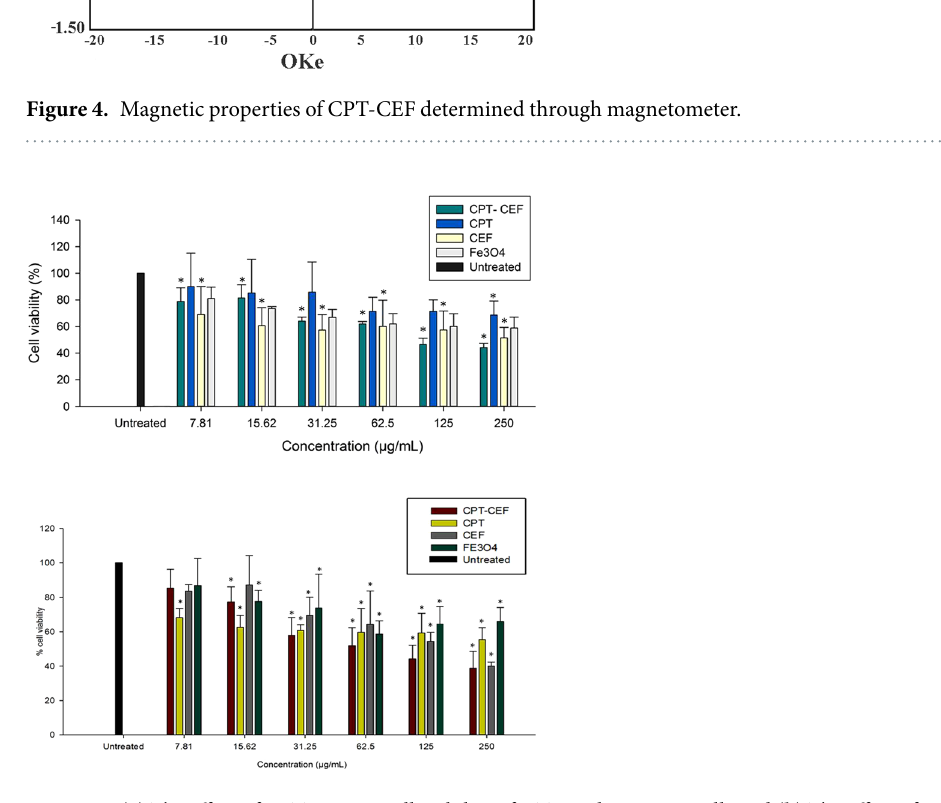
Figure 5. ( a ) The effect of CPT-CEF on cell viability of HT29 colon cancer cells and ( b ) The effect of CPT-CEF on cell viability of A549 lung cancer cells. Cells were treated with various concentrations of CPT-CEF, CPT, CEF and Fe 3 O 4 for 48 h, and cell viability was assessed via MTT assay. CPT-CEF reduced cell viability in HT29 cells in a dose-dependent manner. Results (mean ± SD) were calculated as percent of corresponding control values. * P < 0.05 is significant. Statistical analysis was performed via ANOVA. Each point represents three independent